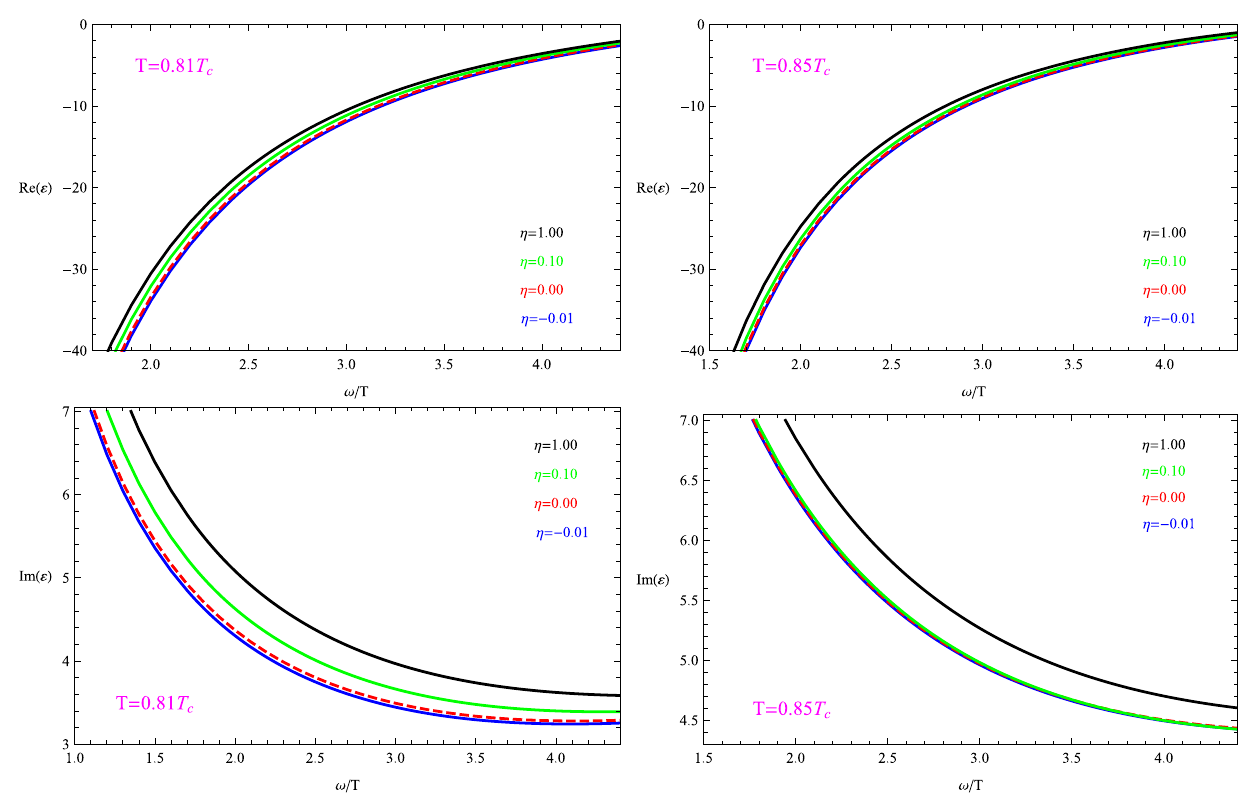
Fig. 8 Real (top) and imaginary (bottom) parts of the permittivity (cid:17) as a function of ω/ T with the fixed temperatures T = 0 . 81 T c (left) and T = 0 . 85 T c (right) for different values of the coupling parameter,